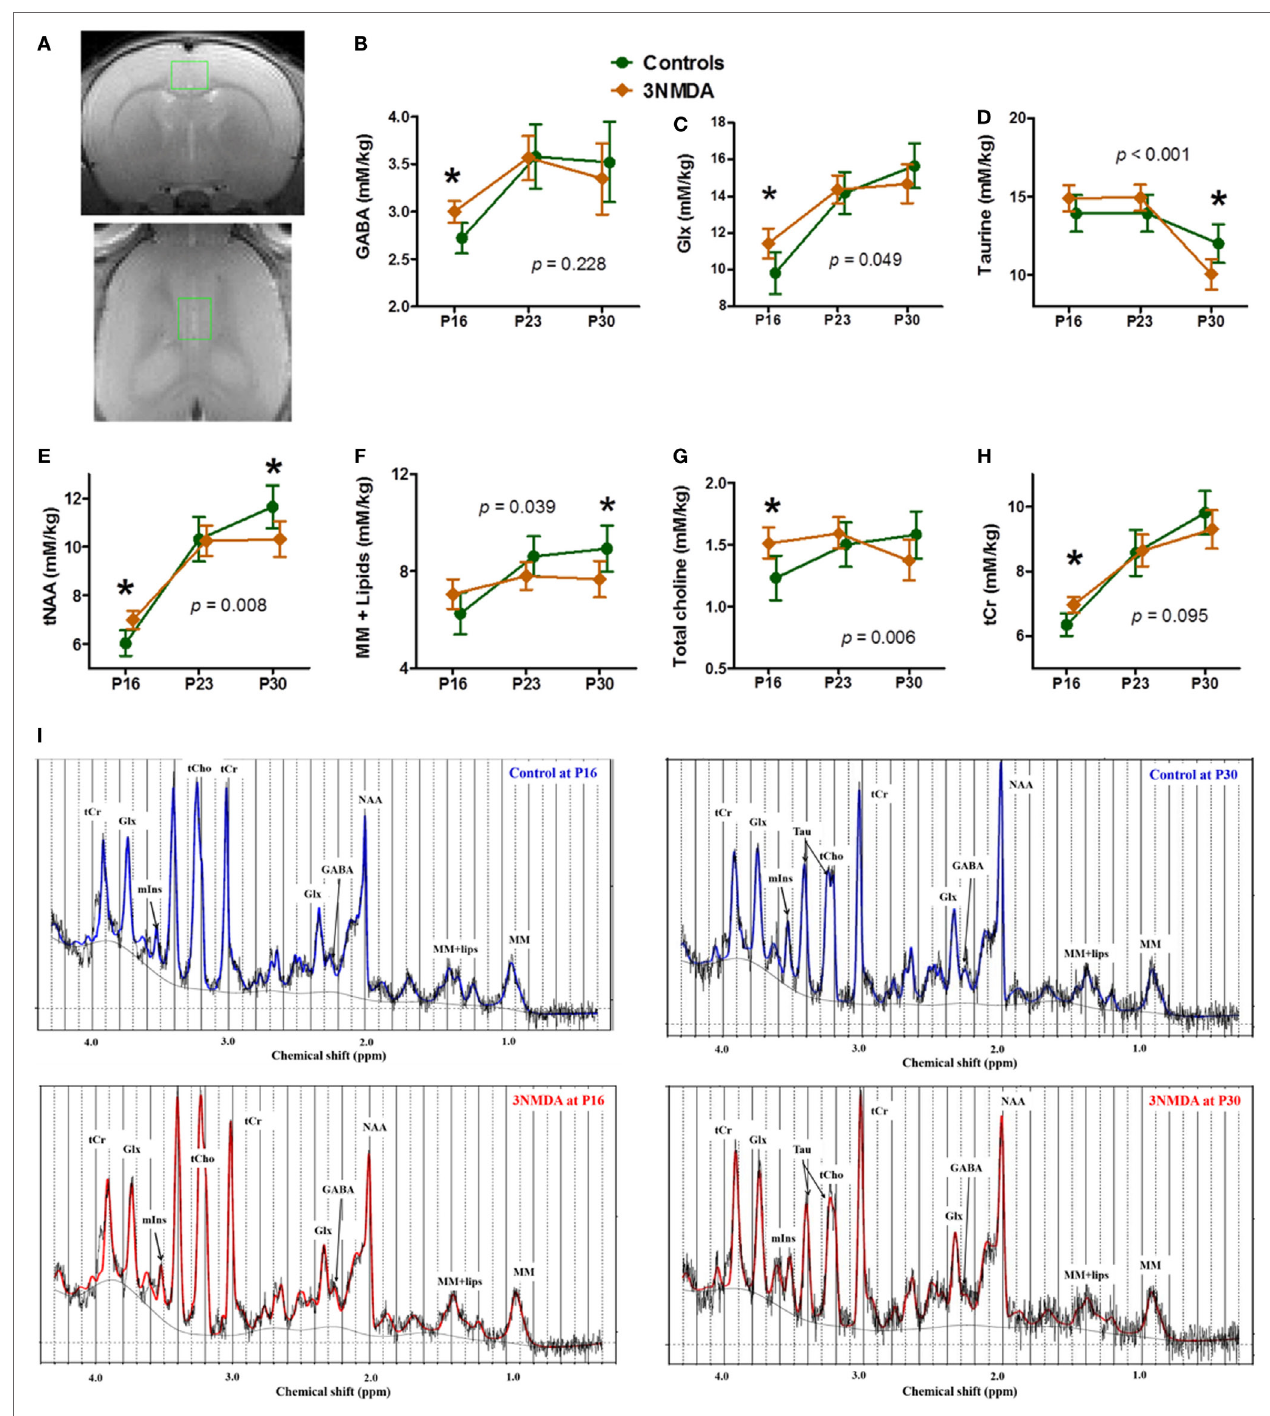
Figure 3 | Neurochemical changes in rats with N -methyl- d -aspartate (NMDA)-induced spasms using 1 H-MRS findings. (a) A single voxel position in the cingulate cortex (top, coronal section; bottom, horizontal section). The brain levels of GABA, glutamine + glutamate (Glx), tNAA, total choline, and tCr were significantly higher in rats with NMDA-induced spasms on P16 (B,c,e,g,h) . (D–F) At 2 weeks, taurine (Tau), tNAA, and macromolecules + lipids (MM + lipids) were significantly decreased in rats with spasms. (c–g) The changes in Glx, Tau, tNAA, MM + lipids, and total choline with time were significantly different between the groups. (i) The examples of MR spectra from rats with or without 3 NMDA spasms on each time points, P16 and P30 clearly shows the neurometabolic changes after NMDA-induced spasms. *indicates a significant difference between the groups at each time point ( p < 0.05). Using a generalized linear mixed model, there were also significantly different interactions between the groups and time points for Glx, Tau, tNAA, MM + lipids, and total choline (each p -value is marked on the graph). All imaging was done on the same timepoints (P16, 23, and 30), although the data points are not aligned across groups to avoid overlapping of the two